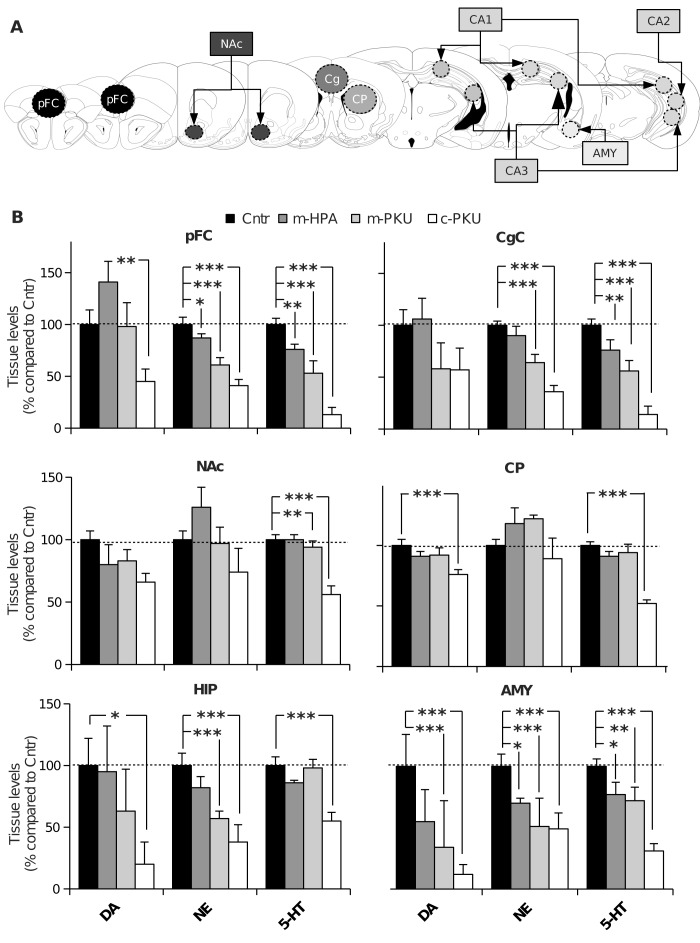
Brain biogenic amine levels in different forms of HPA.(A) Schematic rapresentation of brain areas. (B) Tissue levels of biogenic amines in: preFrontal Cortex (pFC), Cingulate Cortex (CgC), Nucleus Accumbens (NAc), Caudate Putamen (CP), Hippocampus (HIP; CA1, CA2 and CA3 fields) and Amygdala (AMY). Data are reported as percentage + S.E.M compared to Contr group (N=12 for group). Moving from mild HPA to classical PKU forms, data showed progressive impairment in the brain aminergic metabolism. With respect to amine, 5-HT appeared to be most affected and DA the least affected by high blood PHE levels. With respect to brain area, pFC and AMY resulted to be the most susceptible to increased blood PHE levels.
*,***** p<0.05, 0.01, 0.001 from Cntr mice.